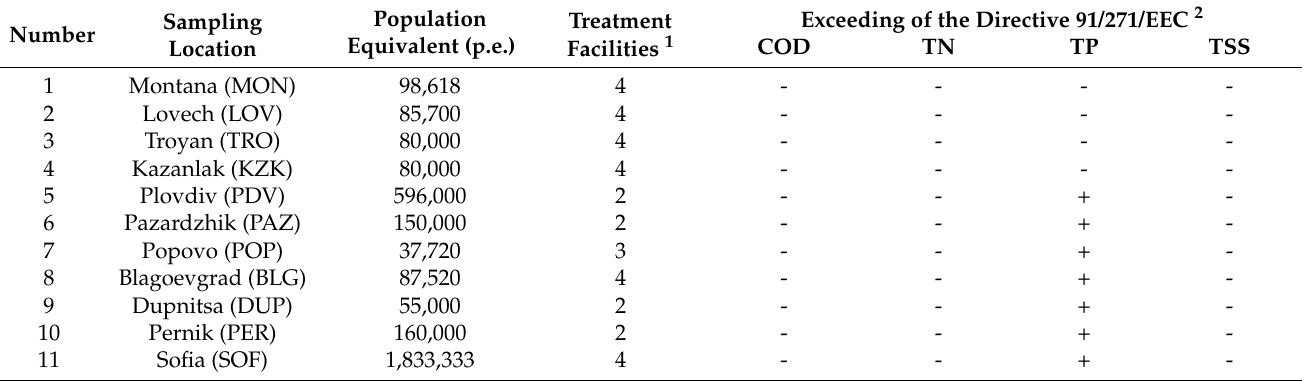
Table 3. Studied WWTPs, population equivalents, treatment facilities and